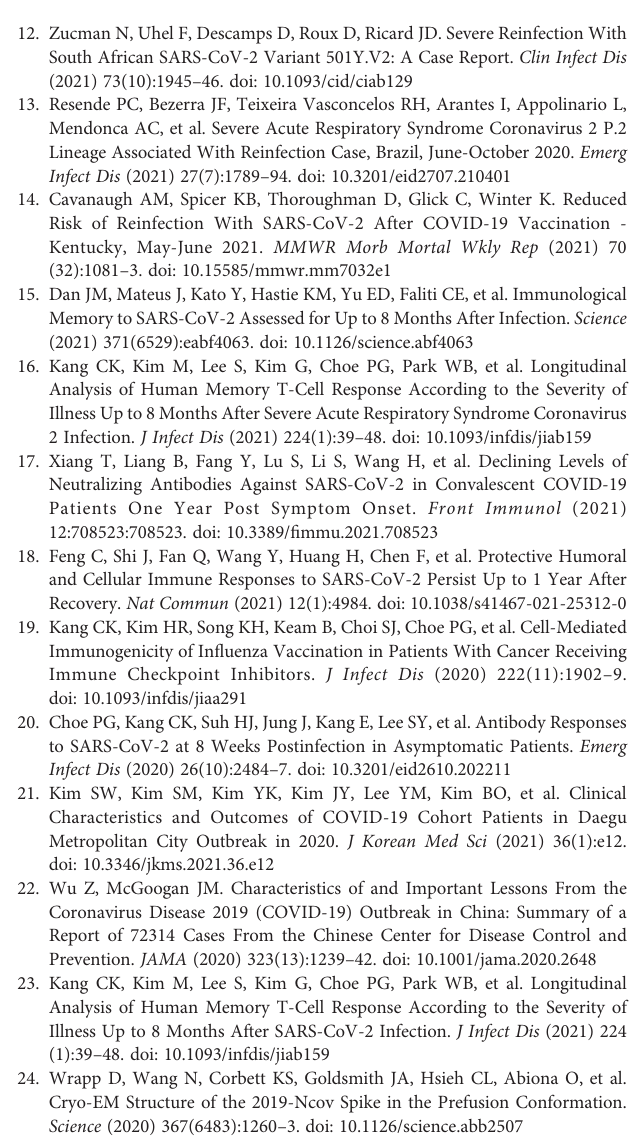
Supplementary Figure S1 | Correlation of antibody response and severity of COVID-19 patients. Each antibody ’ s relative binding activity to SARS-CoV-2- speci fi c protein was presented with severity of COVID-19 patients. Coef fi cient of determination (R2) was calculated by linear regression analysis. ASx: asymptomatic (8-month: n = 7, 12-month: n = 6), Mild (8-month: n = 2, 12-month: n = 9), Severe (8-month: n = 7, 12-month: n = 8). Supplementary Figure S2 | Binding activities of four IgG subclasses to SARS- CoV-2proteins. Dilutedplasma samples(1:100)in PBSwereincubated withSARS- CoV-2 spike, RBD, NC and M protein. Binding activities of IgM, IgA, and IgG to SARS-CoV-2 antigens were determined by proper Abs. HC (2021): healthy control (n = 8), ASx: asymptomatic (8-month: n = 7, 12-month: n = 6), Mild (8-month: n = 2, 12-month: n = 9), Severe (8-month: n = 7, 12-month: n = 8). Statistical analyses were performed using the Kruskal-Wallis rank-sum test withDunn ’ s post hoctest in GraphPad Prism (n.s.: P > 0.05, *P < 0.05, **P < 0.01, ***P < 0.001). Supplementary Figure S3 | Relativebindingactivitiestoeachantigenofanti-SARS- CoV-2 antibody in COVID-19 patients over time. Antibody binding capacity to each